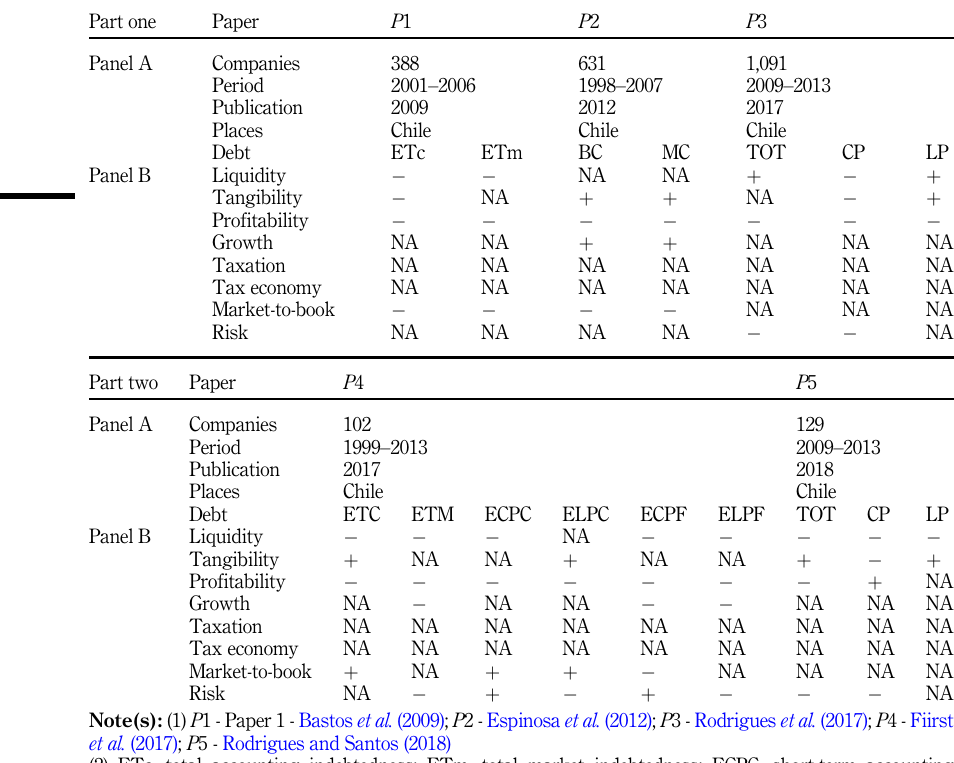
variables with studies of Chilean